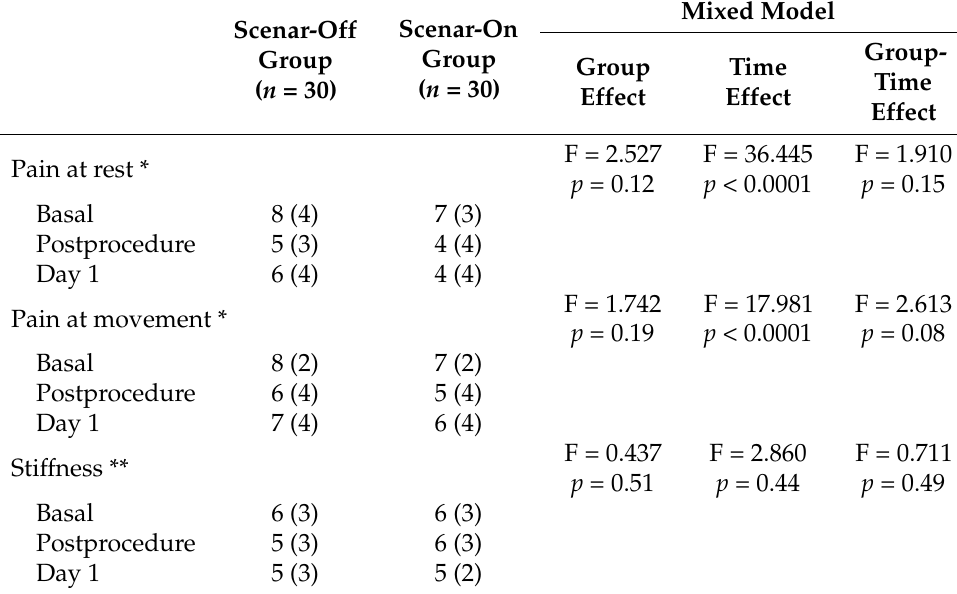
Table 2. Effects of Scenar TM